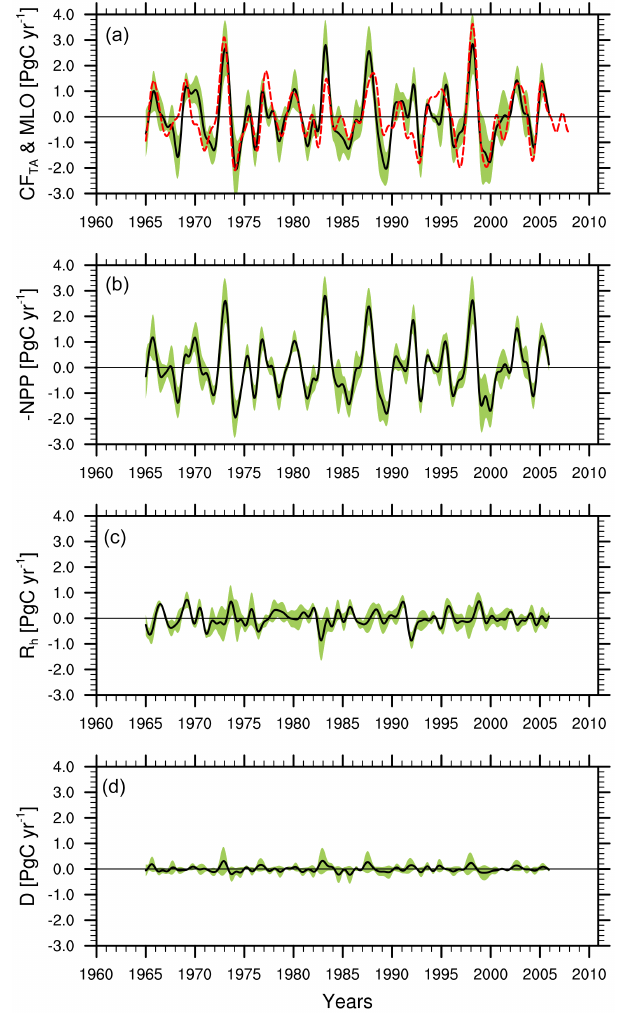
Figure 4. The simulated IAVs of tropical land–atmosphere car- bon flux (CF TA ), reversed net primary productivity ( − NPP), het- erotrophic respiration ( R h ), and disturbances ( D ) by the seven ter- restrial carbon cycle models, involved in the TRENDY project. The solid black lines in the figures denote the ensemble means (ex- cluding CLM4CN), bounded by the 1 σ inter-model spread (green shaded areas). The observed IAVs of Mauna Loa CGR from 1960 to 2012 are also shown in (a) as a red dashed line. We reversed the NPP in order to make the sign consistent, positive values indicate carbon release from the terrestrial